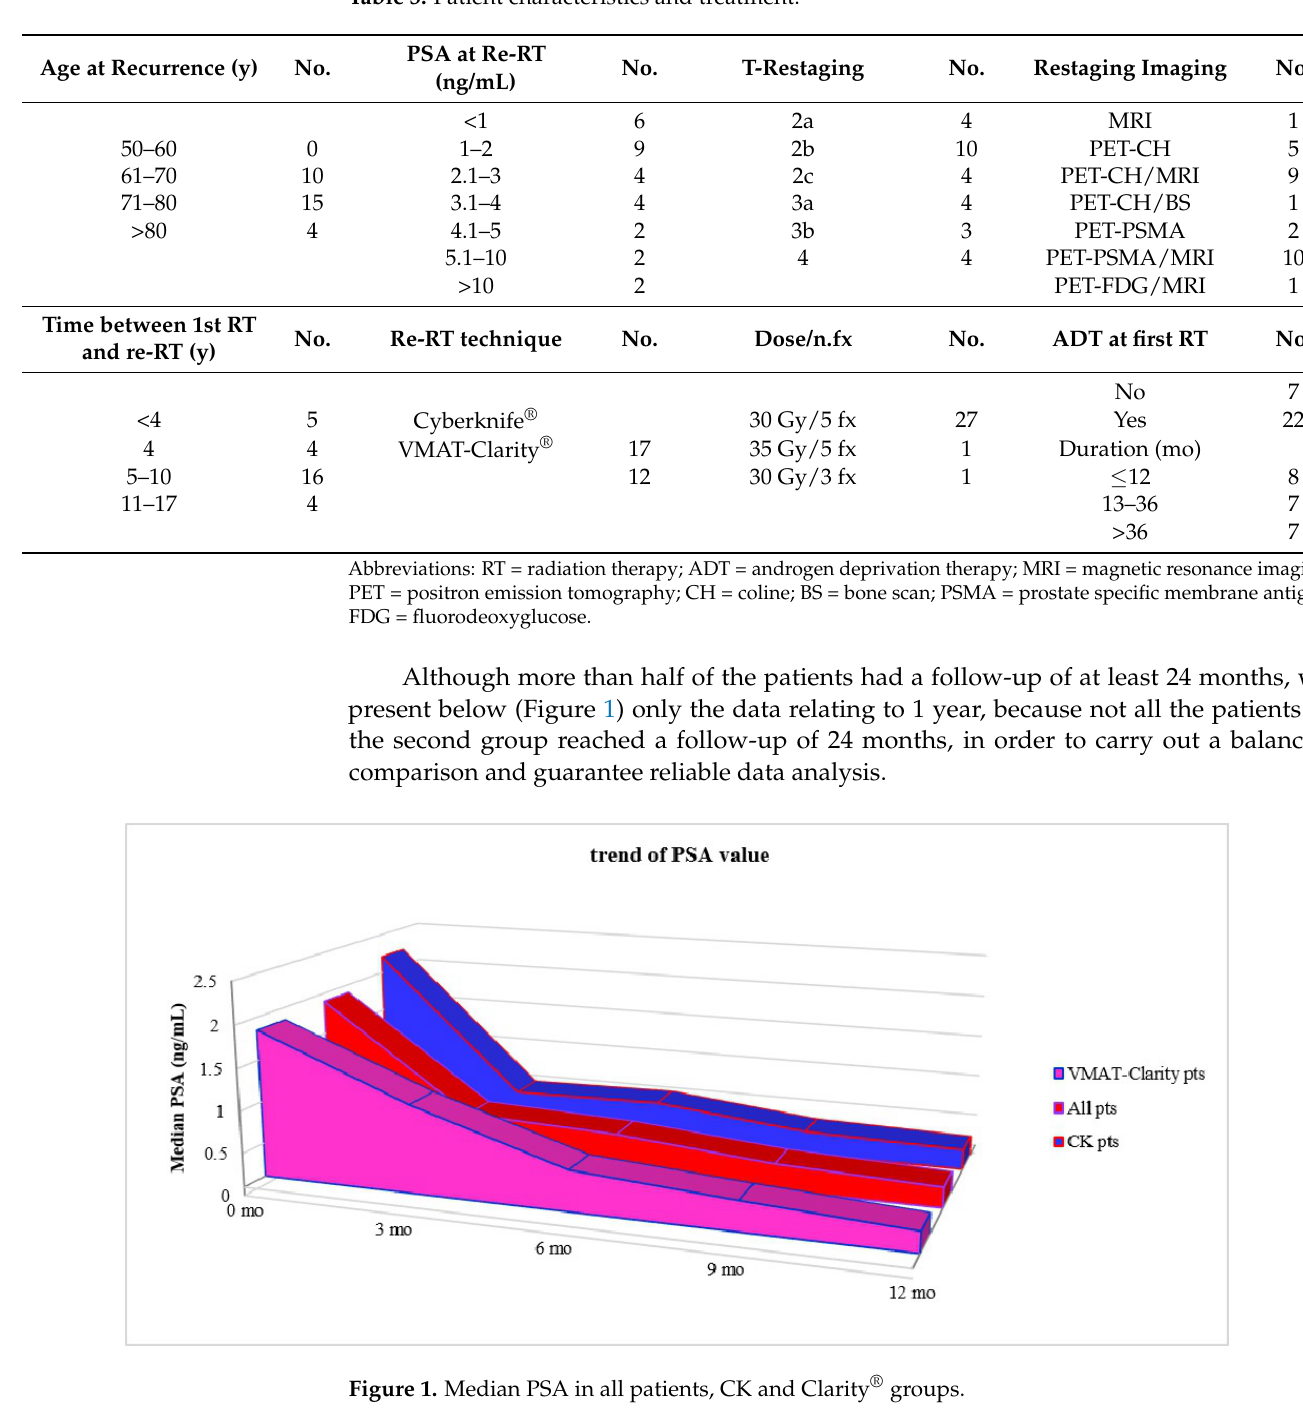
Table 3. Patient characteristics and treatment.